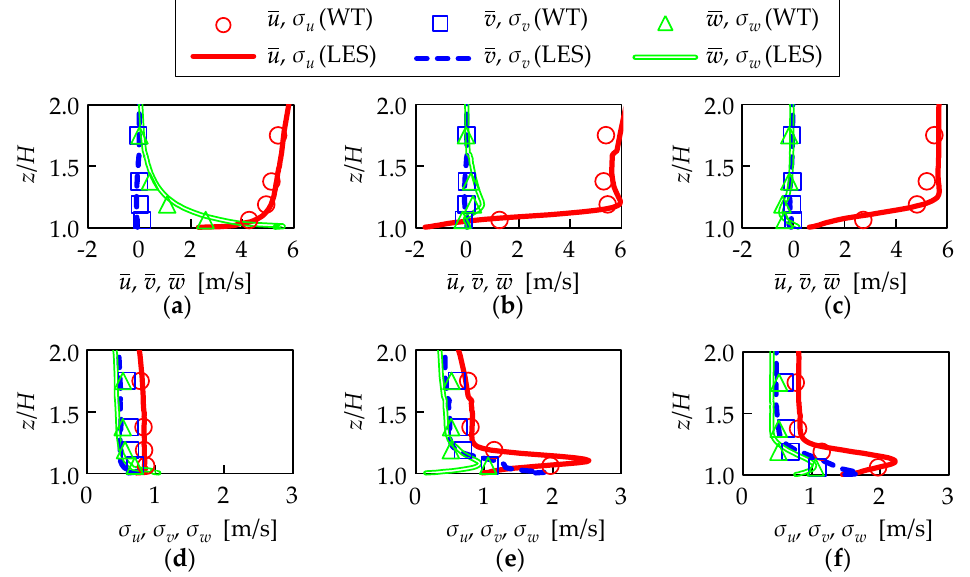
Figure 4. Comparisons of the vertical profiles of the mean velocities and velocity standard deviations between the LES results for case 100_000 and the wind tunnel measurements of Meng and Hibi [19]. “LES” represents the LES results from the present study, and “WT” represents the wind-tunnel observations from Meng and Hibi [20]. ( a ) Mean velocities at L1; ( b ) Mean velocities at L5; ( c ) Mean velocities at L3; ( d ) Standard deviations at L1; ( e ) Standard deviations at L5; ( f ) Standard deviations at L3.